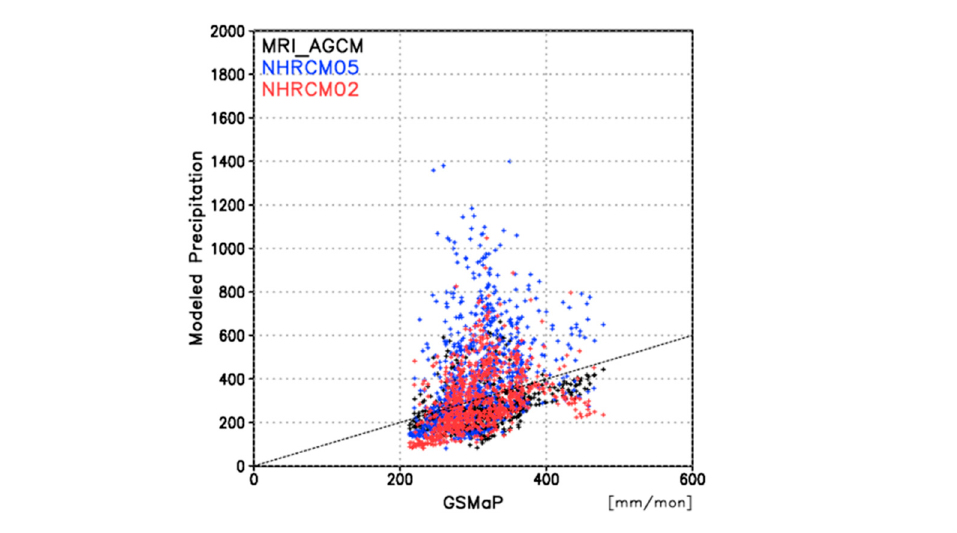
Figure 6. Scatter plot showing 20-year mean annual precipitation amount of GSMaP and NHRCM02. Black dots represent values (in mm/month) for entire domains including oversea areas, and blue dots represent values for land areas only.